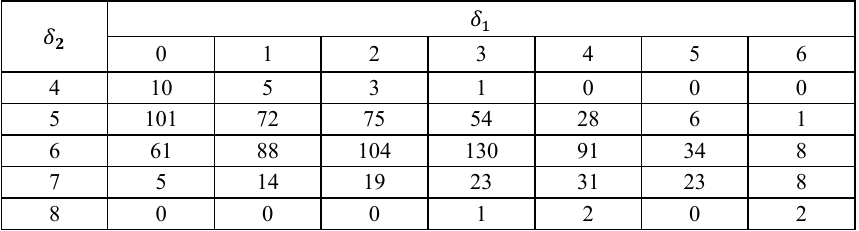
Table 4. Number of corresponding experimental samples when